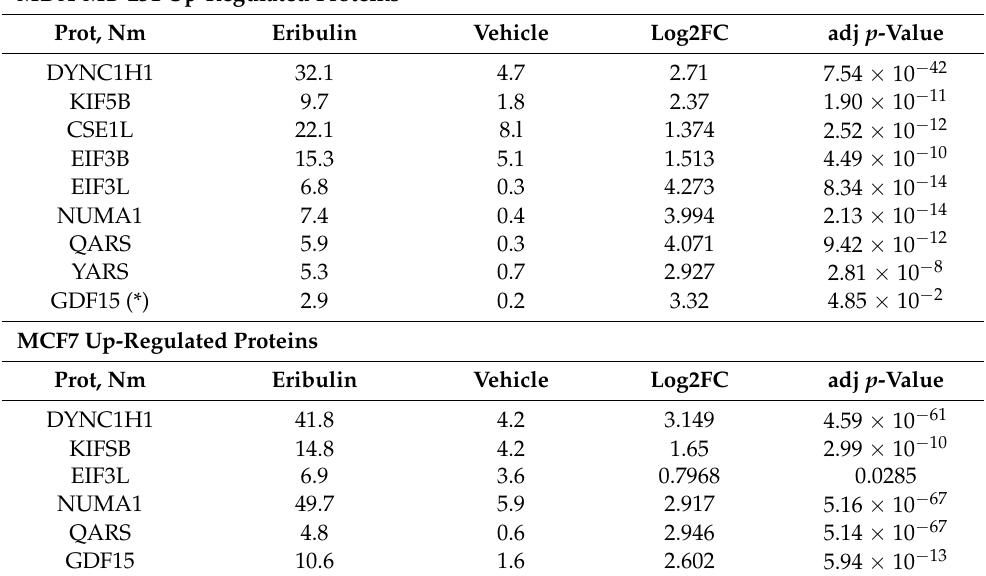
Table 1. List of eribulin-induced secreted candidate biomarkers. Representative analysis of one out of three biological replicates of spectral count data after exporting it from Scaffold software. Adjusted p -value < 0.05, fold change > 0.8 and number of spectral counts (SpC) > 4 thresholds were applied during the analysis. (*) Spectral counts of GDF15 protein in the MDA-MB-231 cell line as evidence that it did not appear in the volcano plot for the thresholds considered in the analysis as described in Material and Methods